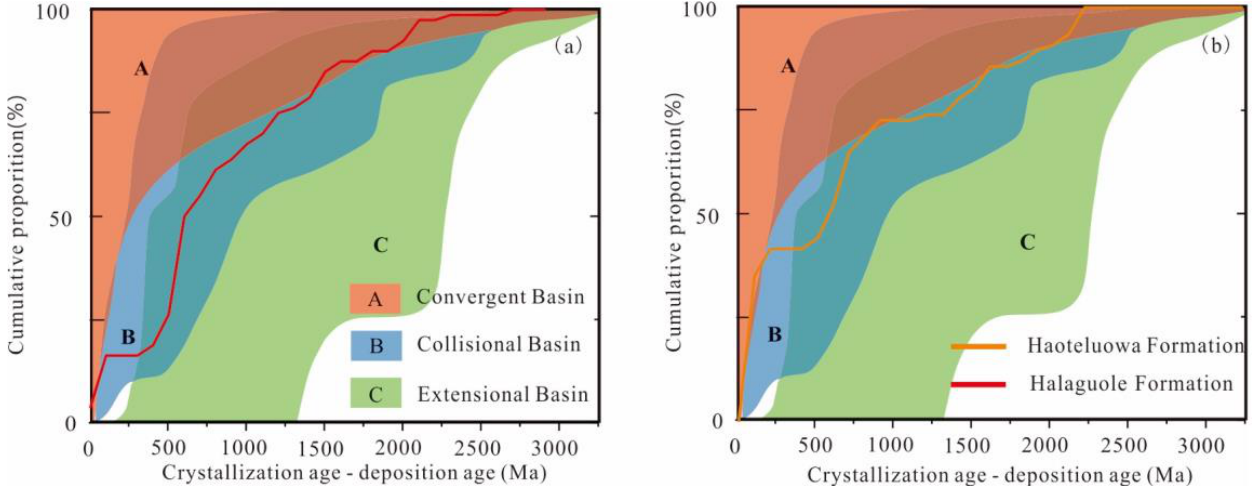
Figure 10. Cumulative probability curve of the difference between the crystalline age and sedimentary age of detrital zircons from the Carboniferous sandstones in the Alake Lake area (after Cawood et al. [71]). ( a ) the crystalline age and sedimentary age of Halaguole formations, ( b ) the crystalline age and sedimentary age of Haoteluowa formations.